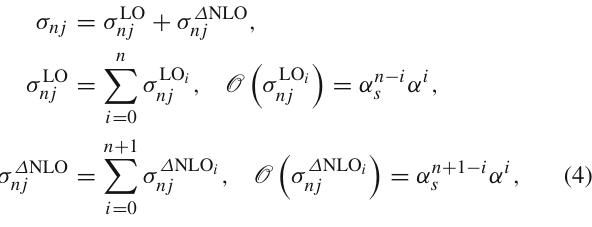
top quark (double line) exchange as well as external photons are exem- plified. While QCD vertices are marked by a black dot, EW interactions are indicated in